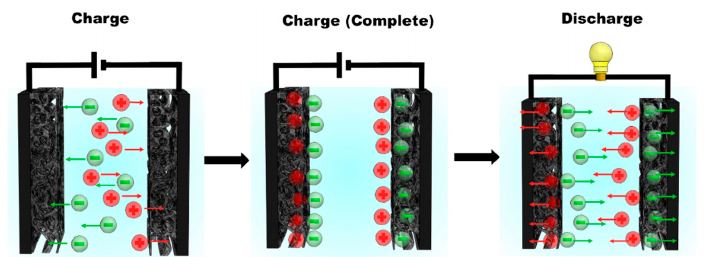
Figure 2. The charging/discharging cycles of a carbon-based supercapacitor.